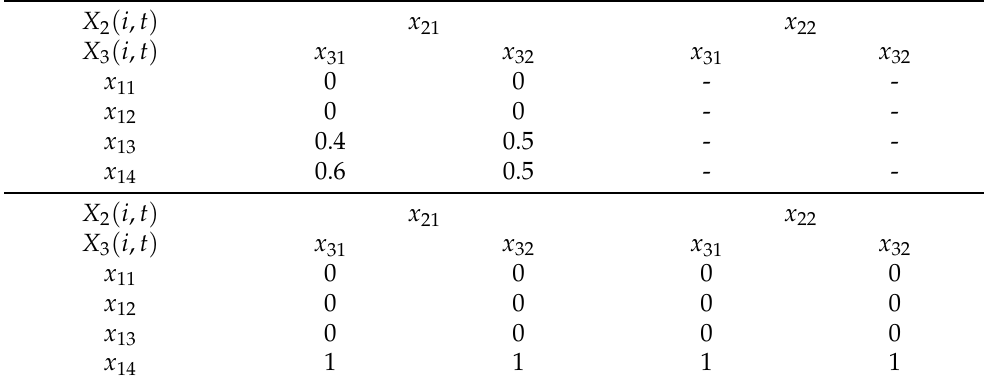
Table 13. CPDs of the future state with more than four infectious devices and with initial states: damaged (on the left) and recovered (on the right).